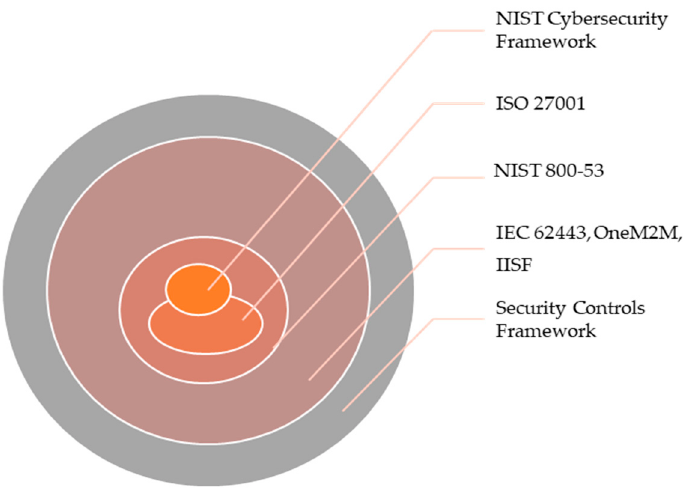
Figure 4. Hybrid security standards and controls adapted from [40].